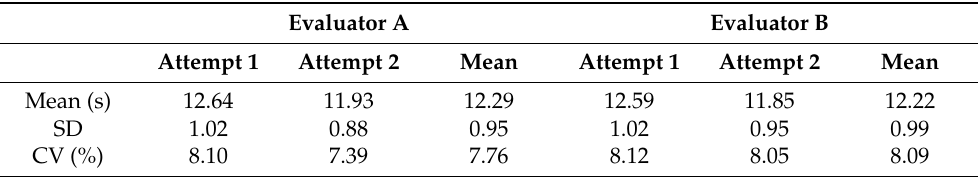
Table 1. Results of the agility test measurements recorded by Evaluators A and B. Mean, standard deviation (SD) and coefficient of variation (CV).